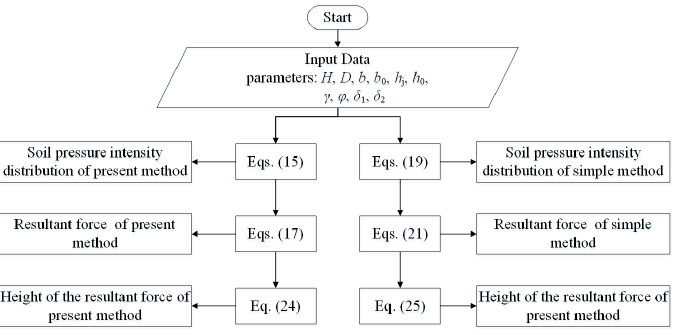
Figure 17. Calculation flow chart.